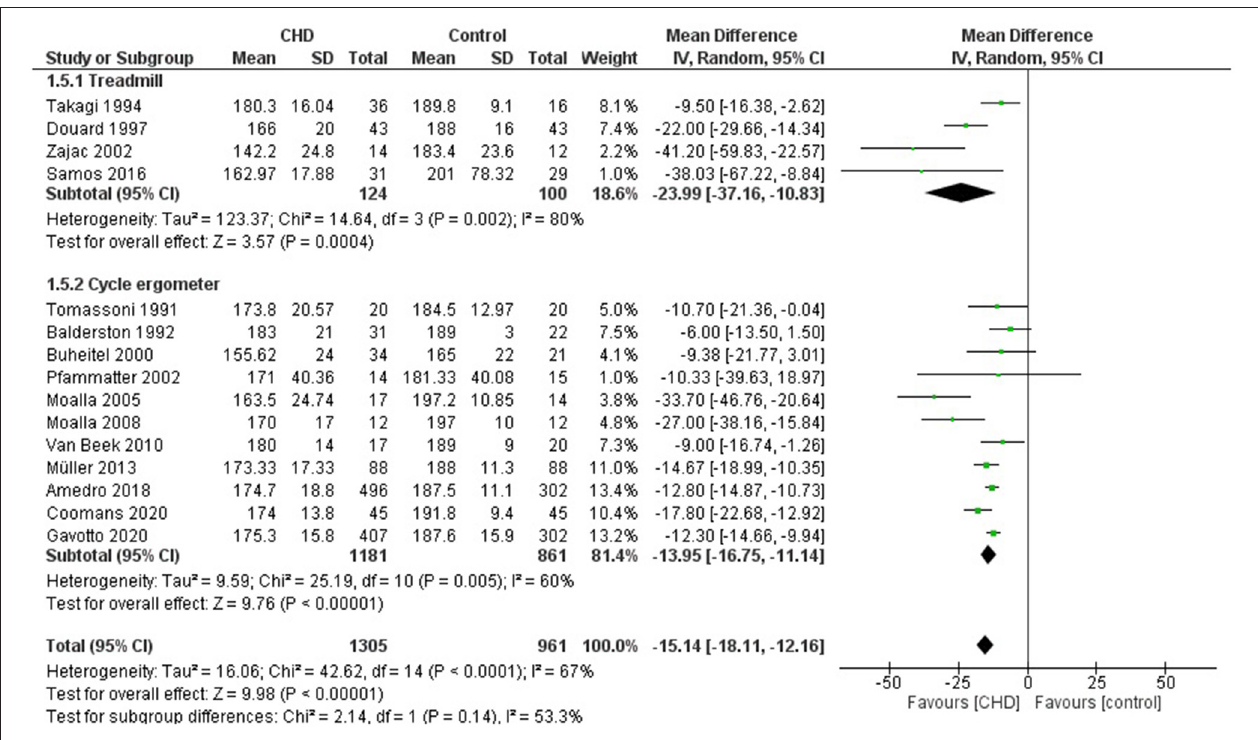
FIGURE 8 | Forest plot for maximum heart rate for CHD in children and adolescents and healthy controls.